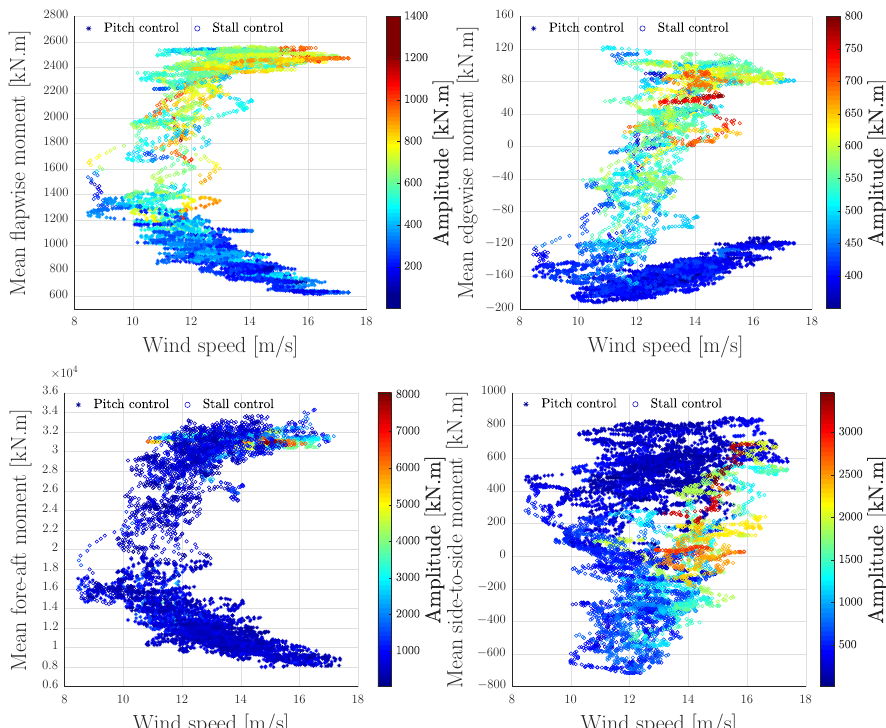
Figure 18. Comparison of the fatigue loads on the structure of the WP wind turbine operating with pitch-to-stall and pitch-to-feather control in the turbulent